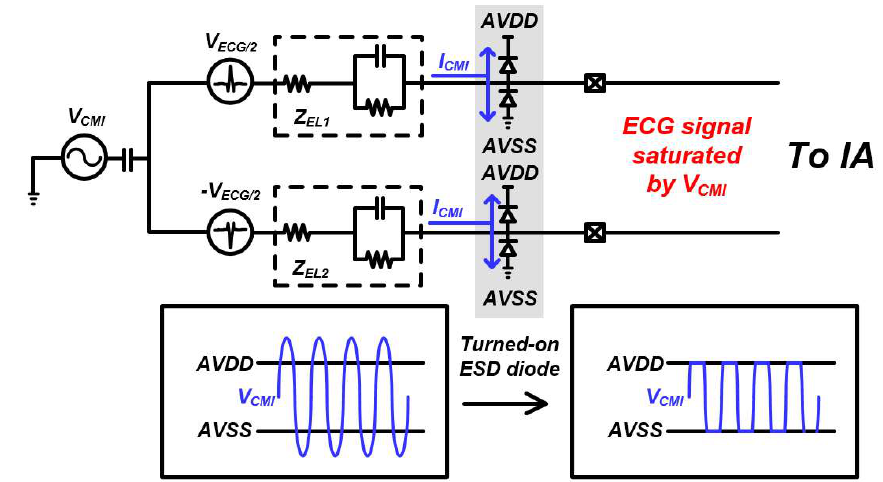
Figure 2. Two-electrode recording saturated by CMI without CMCP topology.